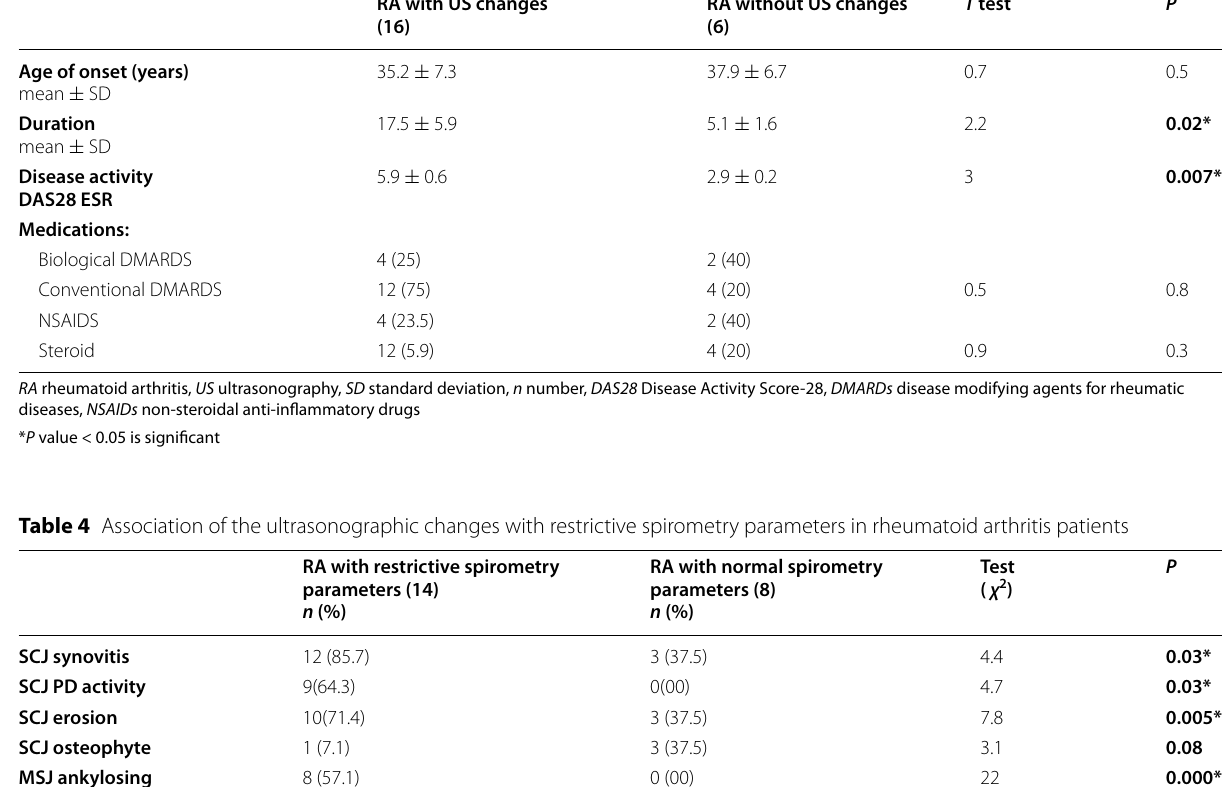
Table 3 Association of the clinical characteristics with ultrasonographic changes in the ACW joints in rheumatoid arthritis patients